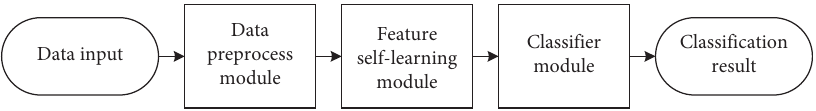
Figure 4: CNN-based network intrusion detection architecture.